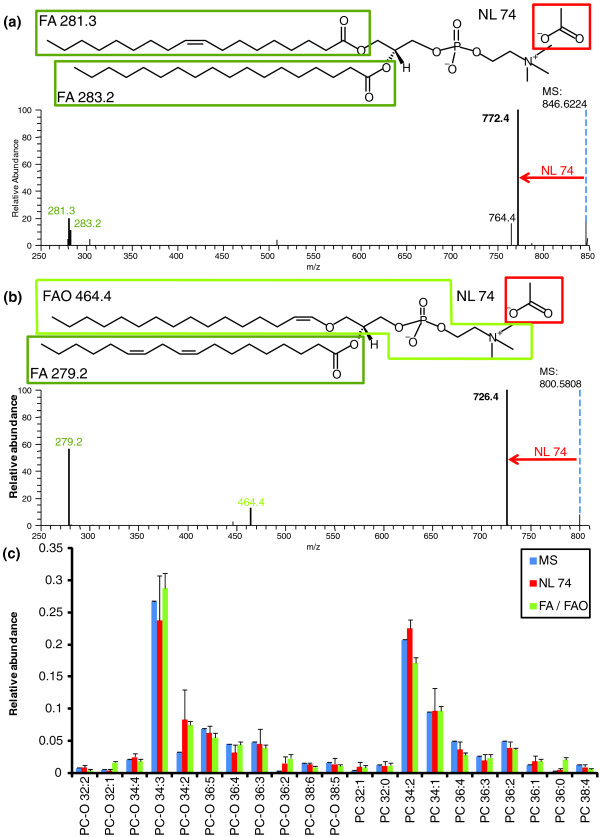
Identification of PC and PC-O species by MFQL queries relying on complementary signature ions. (a) MS/MS spectrum of the precursor ion of the acetate adduct of PC 36:1 (m/z 846.6224), in which four signature ions are recognized: molecular ion (MS); fragment of neutral loss of acetate and methyl group (Δm/z = 74.0 (NL)); acyl anions of the two fatty acid moieties (FA 281.3 and FA 283.2; both boxed in the chemical structure at the top). (b) MS/MS spectrum of the acetate adduct of PC-O 34:3 (m/z 800.5808). Signature ions are the same as in (a), except m/z 464.4 representing the fragment produced by neutral loss of the sn-2 fatty acid moiety. (c) Quantitative profiles of PC and PC-O species reported from abundances of different signature ions. MS, precursor ions in MS spectra; NL 74, neutral loss Δm/z 74 in MS/MS spectra; FA/FAO, acyl anions of fatty acid moieties and (for PC-O) neutral loss of sn-2 fatty acid moiety. The relative abundance of species was normalized to the total abundance of species within each (PC or PC-O) class.